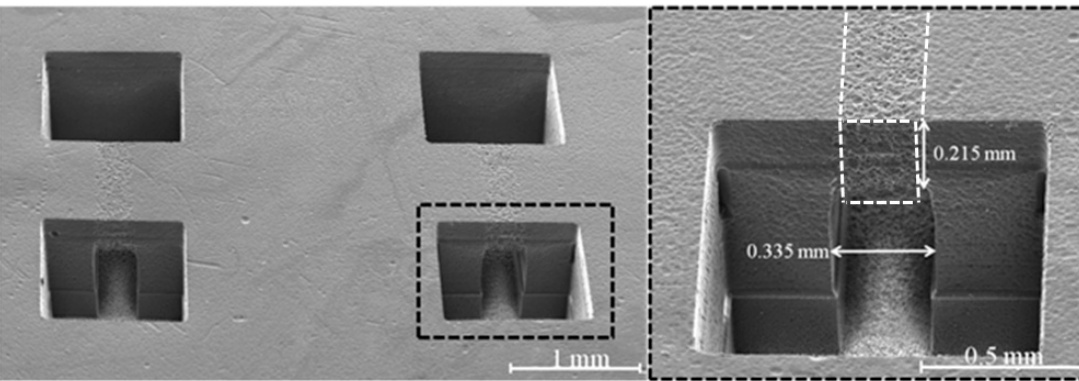
Figure 6. SEM images of twin structures fabricated by UV-PLAE using a ps laser of 12 mW laser power and 5 μ m interline spaces, at 0.5 mm/s scanning speed. The laser irradiation was carried out using two-layer configuration: (on the surface (first layer) and at 500 μ m depth (second layer)).